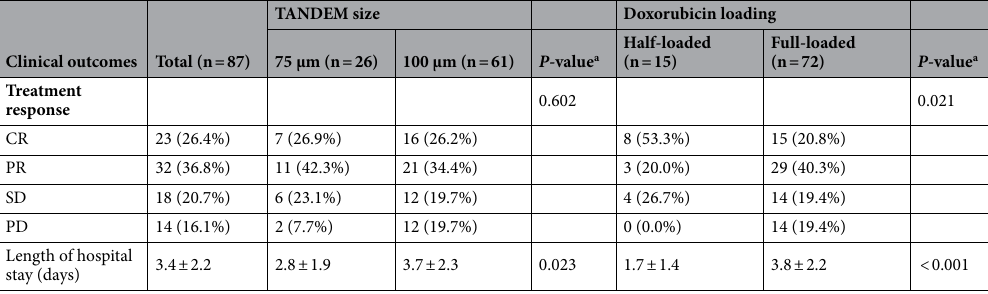
Table 4. Treatment response and length of hospital stay after treating with different TANDEM size or doxorubicin-loading dose. Tumor response was evaluated 3 months after TACE treatment. CR complete response, PR partial response, SD stable disease, PD progressive disease.